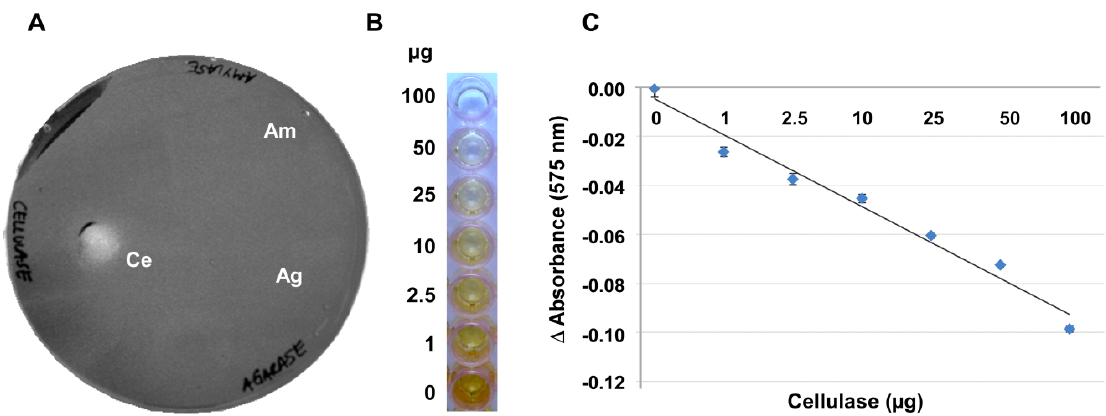
Figure 2. Cellulase activity can be detected on pure solidified CMC without unwanted artifacts. ( A ) Assay in petri dish format: Gram’s iodine detection of 5 μ g cellulase (Ce), 5 μ g amylase (Am) and 5 μ g agarase (Ag) spotted onto 7% solidified CMC; and ( B , C